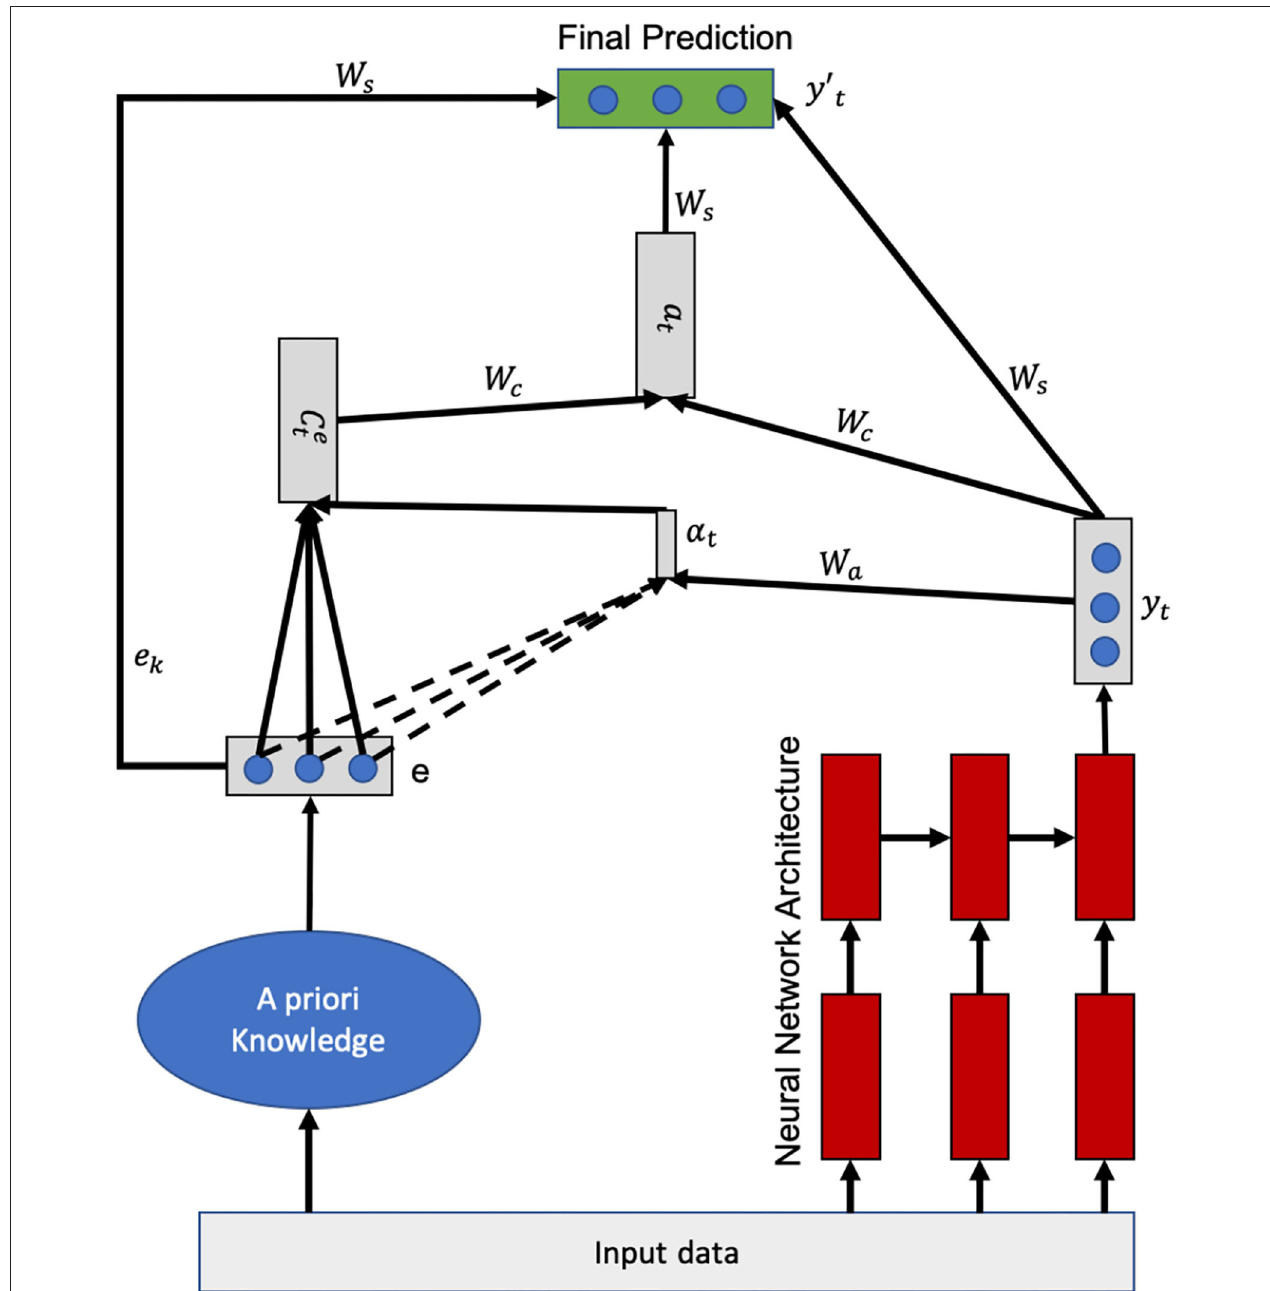
FIGURE 2 | Global attentional hybrid